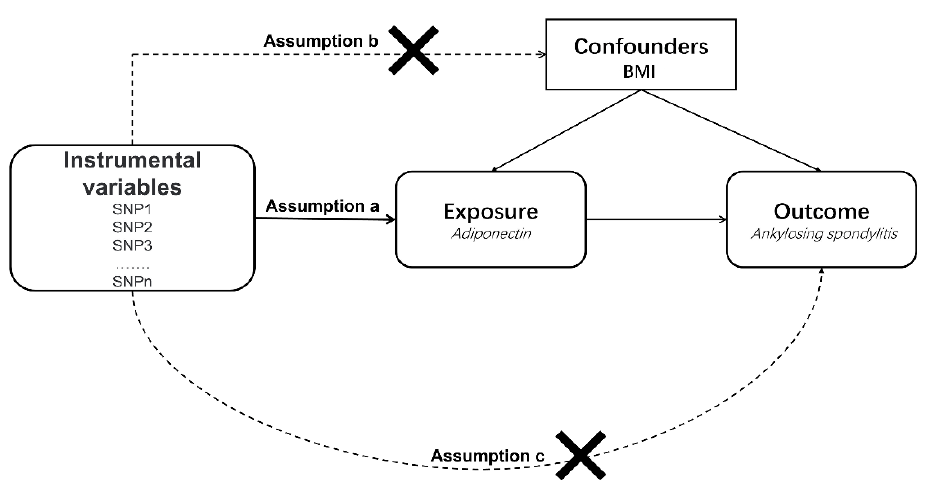
Figure 1. An overview of the study design. SNP, single-nucleotide polymorphism; BMI, body mass index.